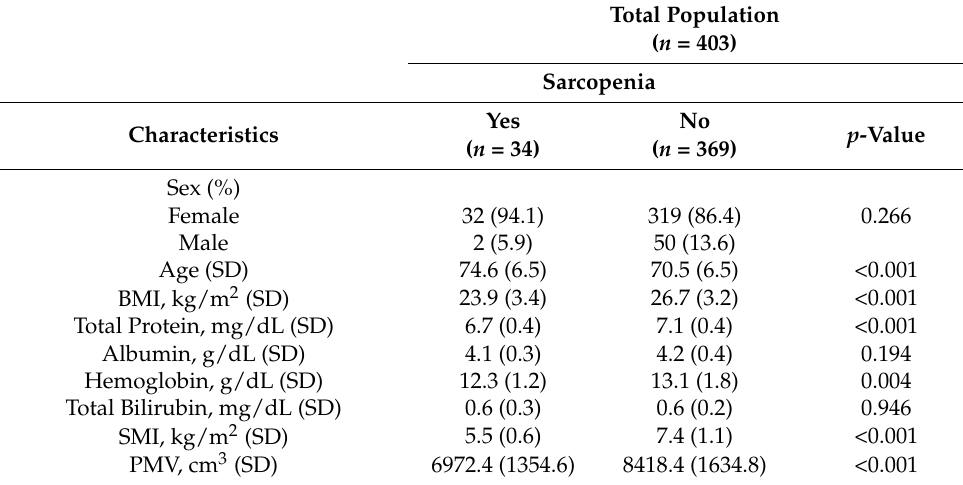
Table 1. Key features comparison of the sarcopenia and nonsarcopenia